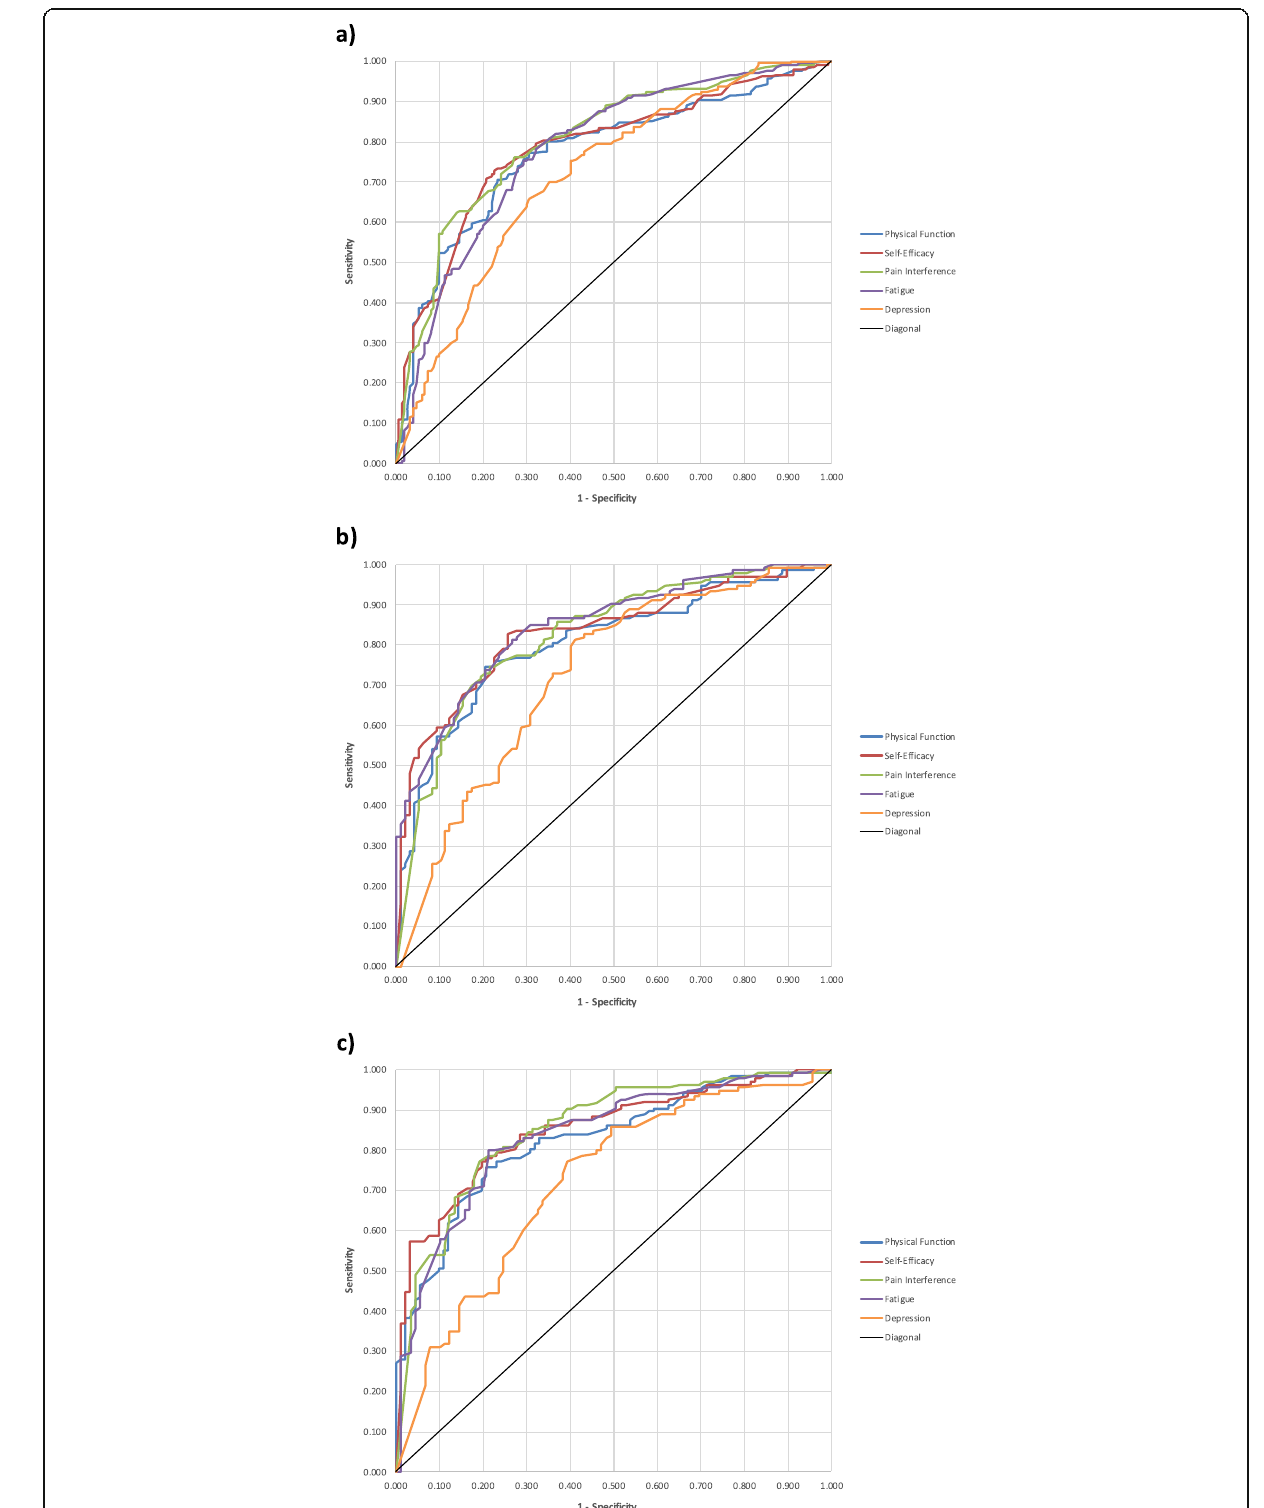
Fig. 1 Receiver-operator characteristic curves for the five PROMIS measures ’ ability to discriminate patient acceptable symptom state (PASS): (a) intake, (b) 3 – 14 day follow-up, (c) 45 – 60 day